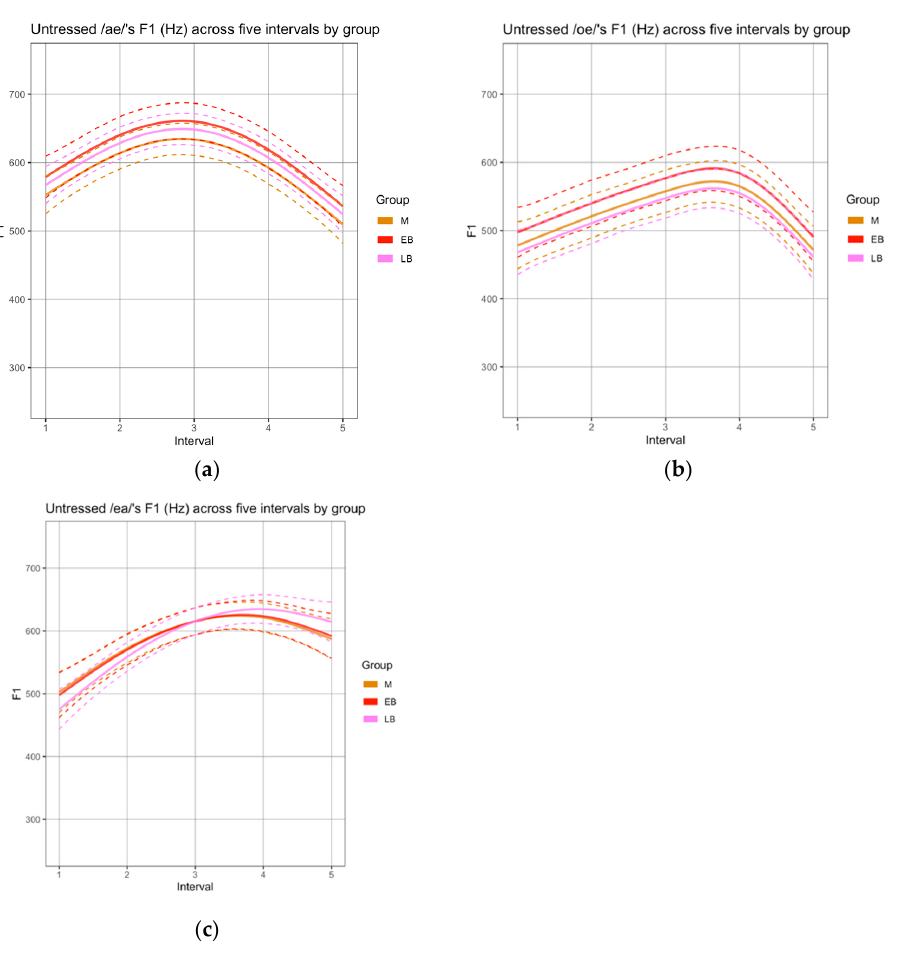
Figure A1. SSANOVAs for non-normalized (female) F1 trajectories across five intervals within the sequences ( a ) /ae/; ( b ) /oe/; and ( c ) /ea/ produced by each group of speakers (M, EB, LB) in the reading task.